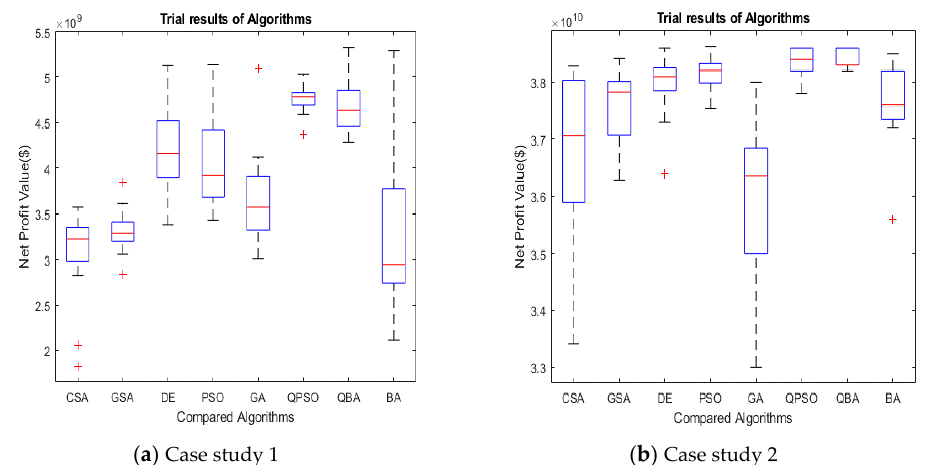
Figure 7. Box plot for PSO, GSA, CSA, and NCSA for case study 1 and case study 2.